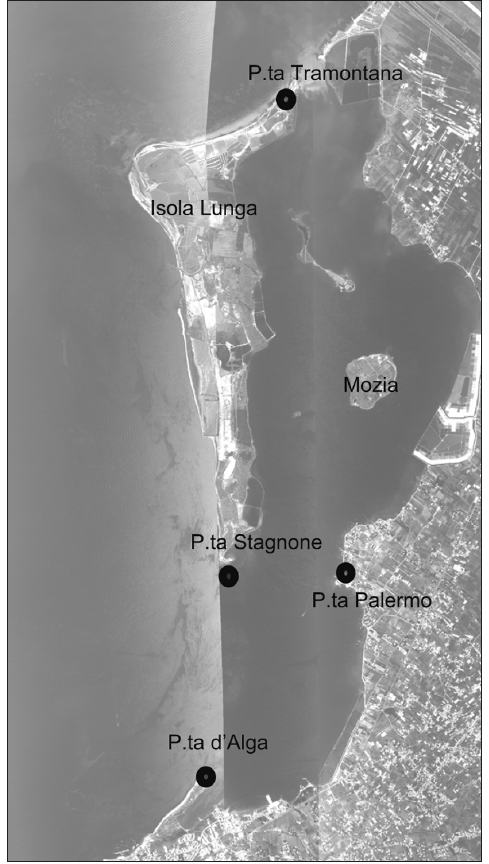
Fig. 1. Study area – MIVIS image